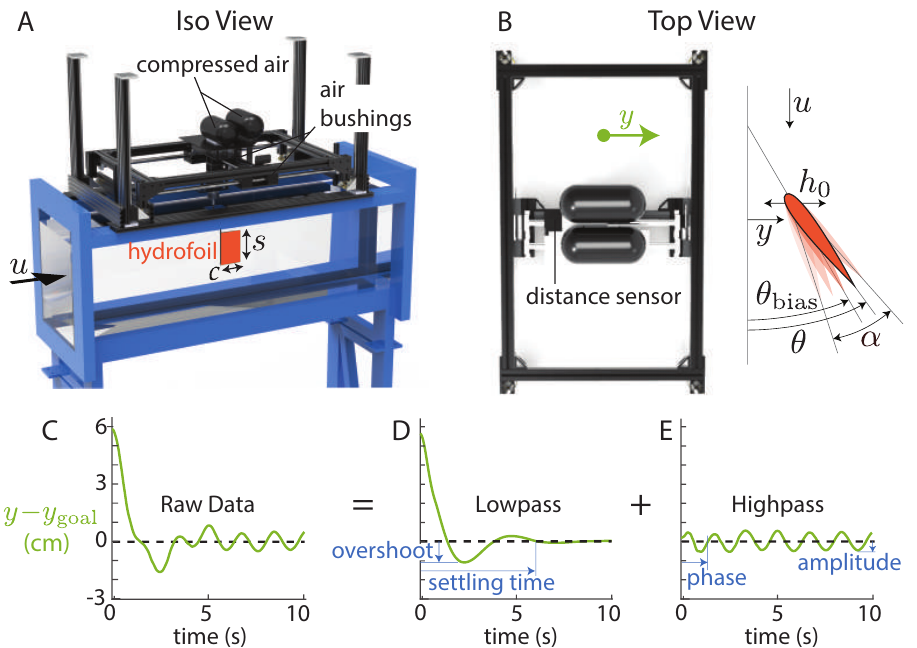
Figure 1. A pitch-biased hydrofoil suspended from air bushings performed lateral maneuvers in a water channel. ( A ) Channel: Rolling Hills 1520; test section: 1.52m long, 0.38m wide, and 0.45m deep. Compressed air at 4500psi. ( B ) Carriage is free to move laterally ( ± y ). The hydrofoil is driven with pitch oscillations ( θ = θ bias ( t ) + α sin ( 2 π ft ) ), leading to passive surging (amplitude h 0 ). ( C – E )